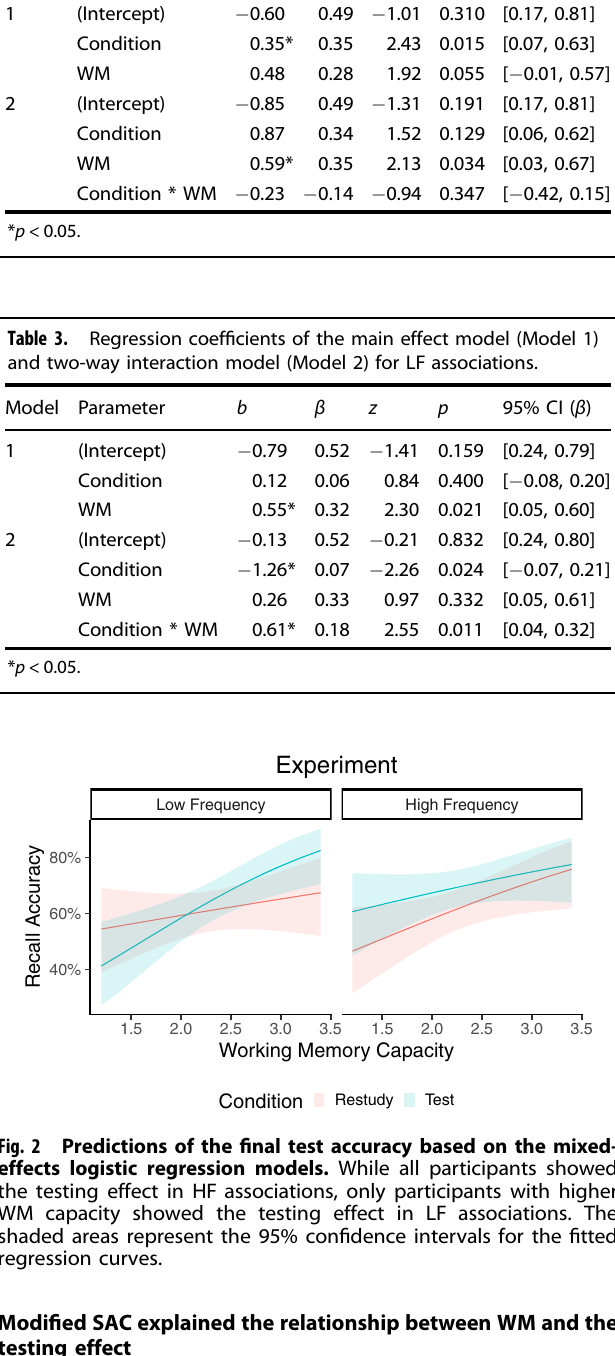
Table 2. Regression coef fi cients of the main effect model (Model 1) and two-way interaction model (Model 2) for HF associations. Model Parameter